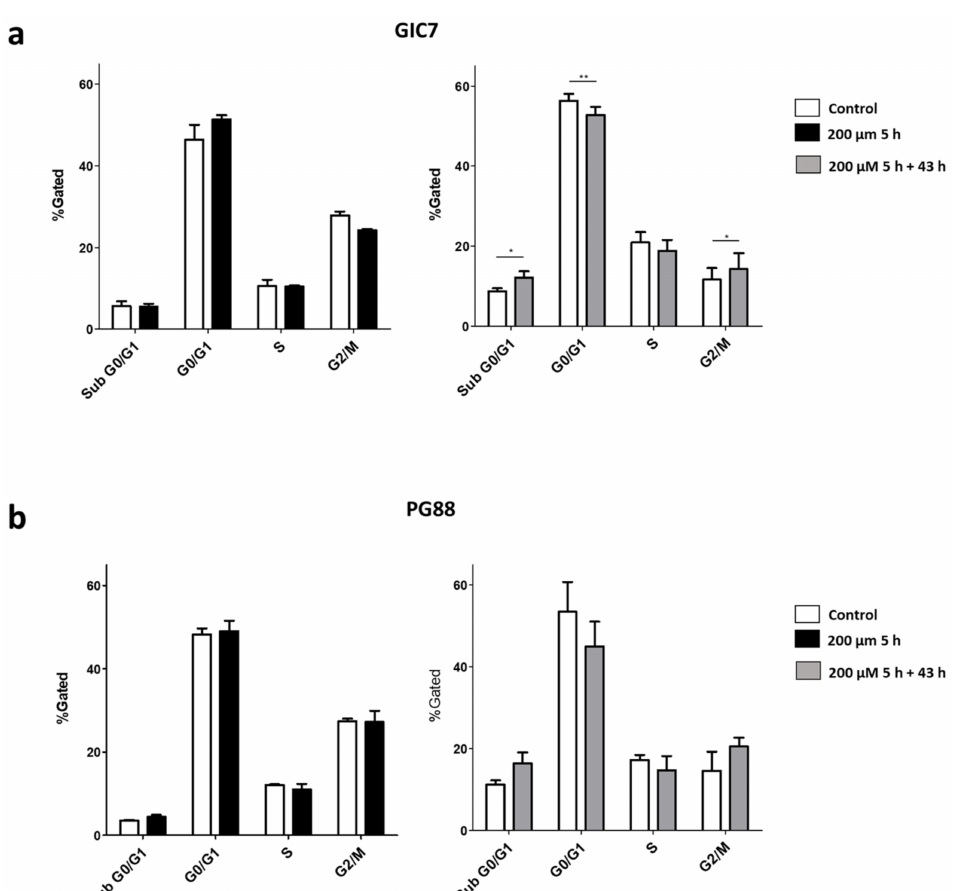
Figure 4. GIC7 and GP88 cell cycle changes induced by 200 µ M Na[ o -COSAN] 5 h treatment. Scheme 7. ( a ) nor PG88 ( b ) concerning their respective untreated controls. ( a ) GIC7 cell cycle at 43 h after washing out the Na[ o -COSAN] (right panel) shows changes of sub G 0, G0/G1 and G2/M statistically significant (ANOVA, * p < 0.05; ** p < 0.01, respectively) ( b ) GP88 cell cycle at 43 h after wash out the Na[ o -COSAN] (right panel) shows some differences in G0/1, G2/M and S phase not statistically